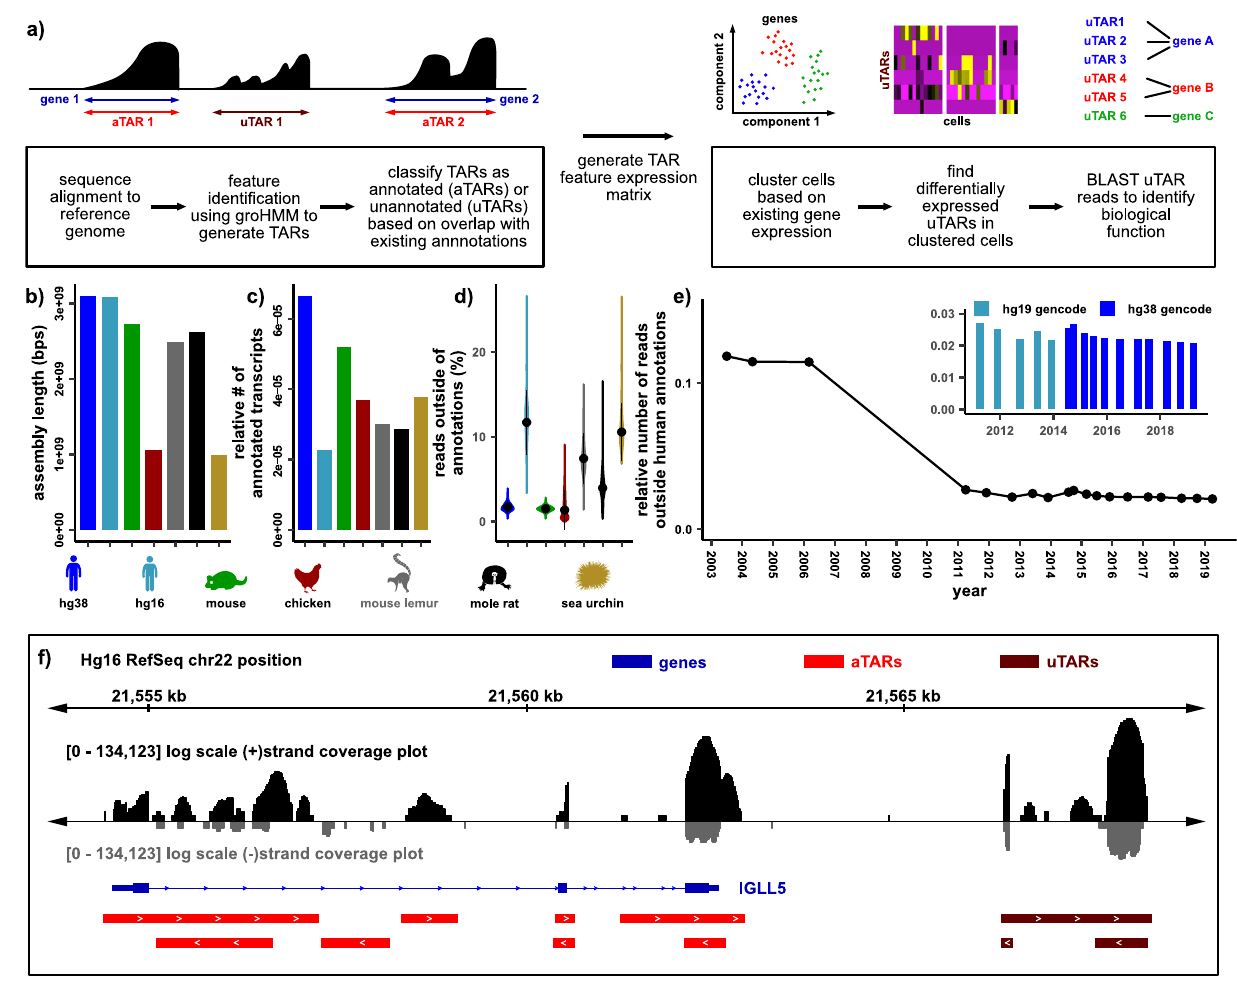
Fig. 1 Generating de novo features based on genome coverage. a Work fl ow to generate TARs and to identify biologically meaningful uTARs. b Total genome assembly sequence length for human (hg38 and hg16), mouse (mm10), chicken (GRCg6a), gray mouse lemur (Mmur_3.0), naked mole rat (HetGla_1.0), and sea urchin (Spur_4.2). c Total number of annotated transcripts in existing annotations normalized to the assembly sequence length for humans (hg38 GENCODE v30, hg16 RefSeq), mouse (GENCODE vM21), chicken (GRCg6a Ensembl v96), gray mouse lemur (Mmur_3.0 RefSeq), naked mole rat (HetGla_1.0 RefSeq), and sea urchin (Spur_4.2 RefSeq). d Relative number of unique scRNA-seq reads outside of gene annotations contained in uTARs for each cell shown as violin plots (3849 cells in hg38 and hg19, 6113 in mouse, 14008 in chicken, 6321 in lemur, 2657 in naked mole rat, 2658 in sea urchin). Mean values (black dots) and 2 standard deviations above and below the mean (black bars) are shown. e Relative number of unique scRNA- seq reads outside of gene annotations for different human genome assemblies and annotations at different times (3849 cells). f Example of groHMM de fi ned aTAR (red) and uTAR (maroon) features along hg16 chr22 with RefSeq hg16 gene annotations shown in blue. Sense strand coverage plotted in black while antisense strand coverage plotted in gray (log-e